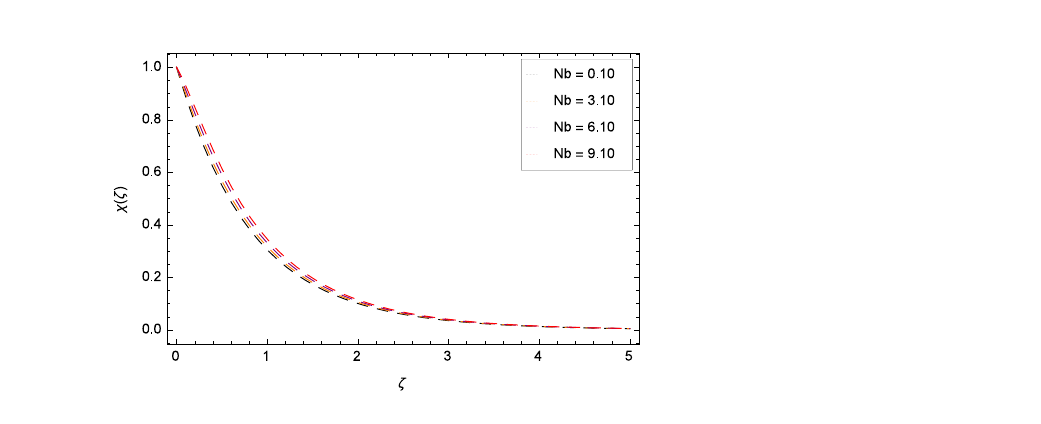
Figure 24. Pattern of graph curves on account of Nb .